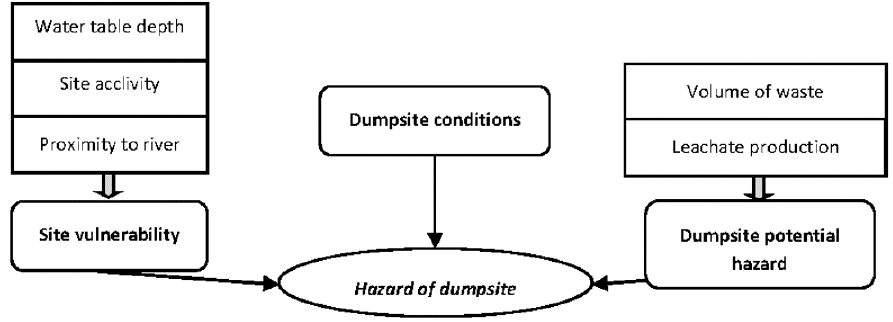
Figure 11. Conceptual diagram of the implemented fuzzy model for dumpsite risk